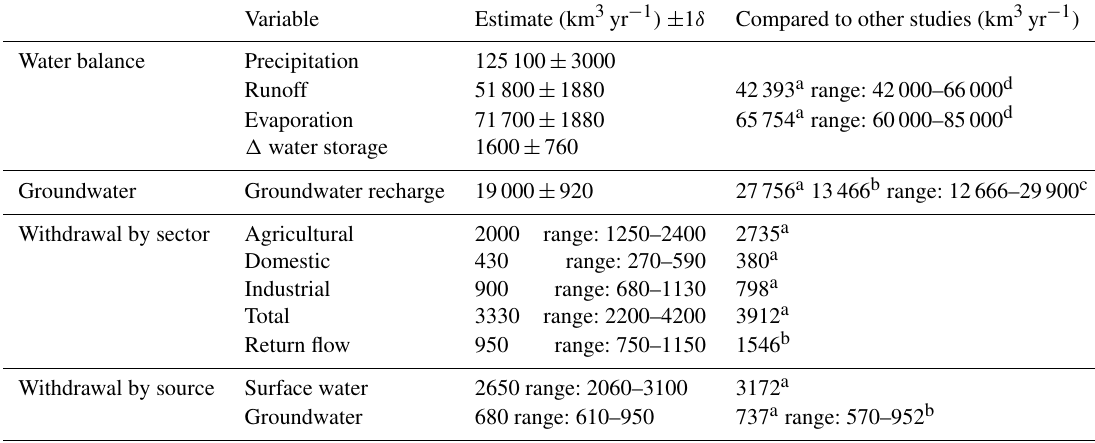
Table 5. Global water balance components over the period 1981–2016 simulated by CWatM.